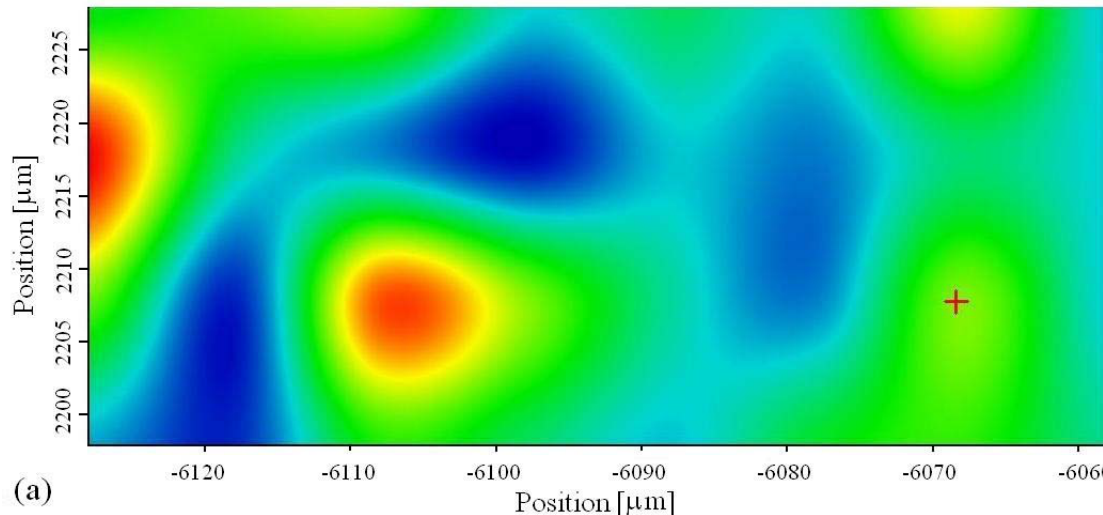
Figure 5. Mapping image of phosphate from tungsten bronze in: (a) 2D; (b)